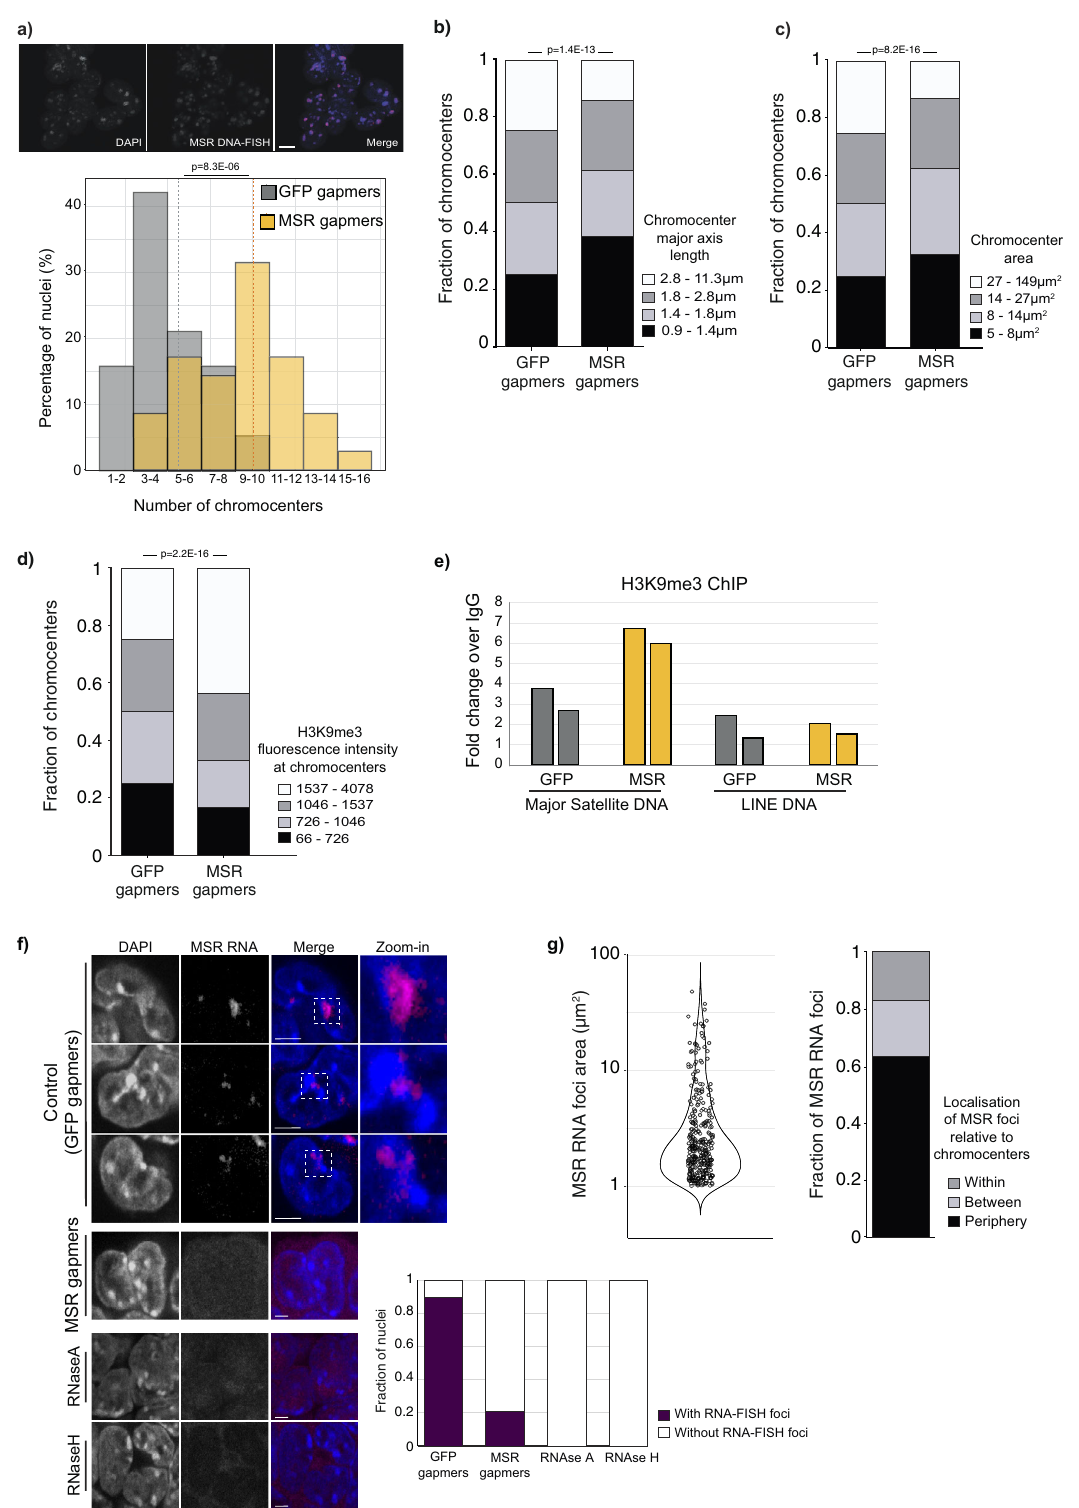
chromocenters (Fig. 4a – c and Supplementary Fig. 4c), an orga- nisational pattern characteristic of differentiated cell types. Dif- ferences in chromocenter organisation when comparing between MSR and GFP gapmer-treated cells was also con fi rmed by line- scan DAPI-analysis (Supplementary Fig. 4d). In addition, immuno fl uorescence microscopy and ChIP revealed the increased accumulation of H3K9me3 at heterochromatin domains after